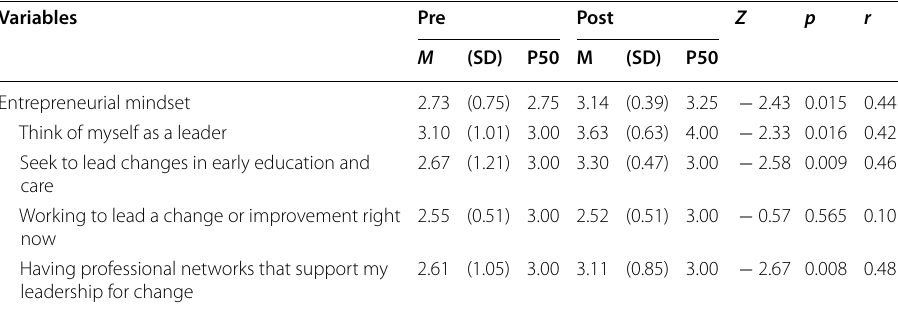
N 31. Wilcoxon signed rank test with continuity correction. P50 = Table 4 Participants’ perceived leadership competencies before and after the leadership initiative